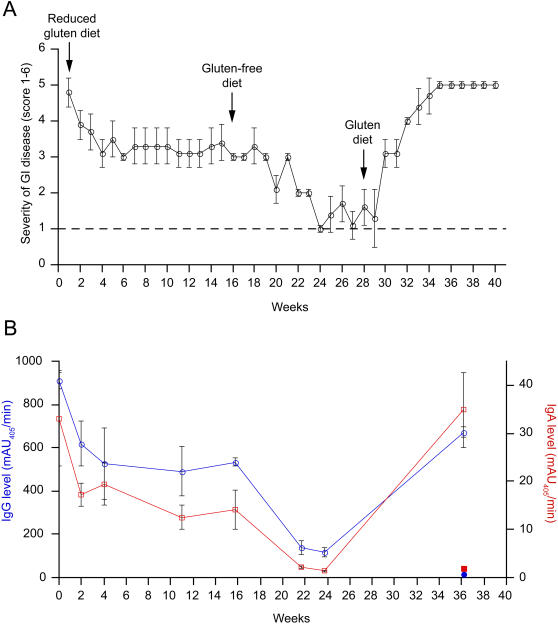
Gluten dependence of clinical symptoms and serology in gluten-sensitive rhesus macaque FH09.(A) Gastrointestinal symptoms in gluten-sensitive FH09 improve with sequential administration of reduced gluten and gluten-free diets, but return upon reintroduction of dietary gluten (diet changes indicated by vertical arrows). Criteria that were used in clinical scoring of gluten sensitivity in the juvenile macaque FH09 were scaled relative to the healthy, age-matched control, FR26 (score 1, indicated by dotted line). Score 2 corresponded to beginning of diarrhea, e.g. pasty stools. Score 3 corresponded to semi-liquid stools and decreased activity. Score 4 corresponded to liquid stools, decreased activity, moderate dehydration and “balloon” stomach. Score 5 corresponded to liquid stools, depression, severe dehydration and balloon stomach. Score 6 would correspond to a moribund animal where prompt euthanasia is recommended. Each datapoint represents the mean of 7 daily measurements taken over the course of the indicated week. Standard deviations are indicated by error bars. (B) Anti-gliadin IgG (blue; open circles) and IgA (red; open squares) return to baseline with dietary exclusion of gluten, but are elevated following reintroduction of dietary gluten. The level of anti-gliadin IgG (blue; closed circle) and IgA (red; closed square) in control FR26 are shown for comparison. Each datapoint represents the mean of triplicate measurements. Standard deviations are indicated by error bars.